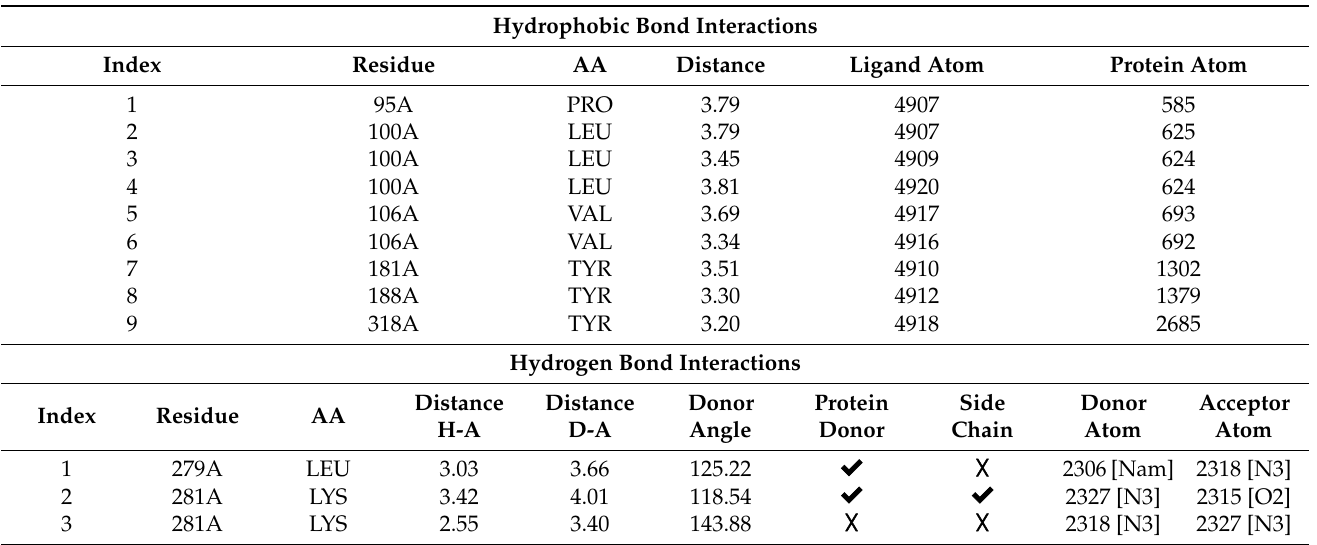
Table 2. Hydrophobic and Hydrogen bond interaction details of HIV-1RT and C-PC. Hydrophobic Bond Interactions